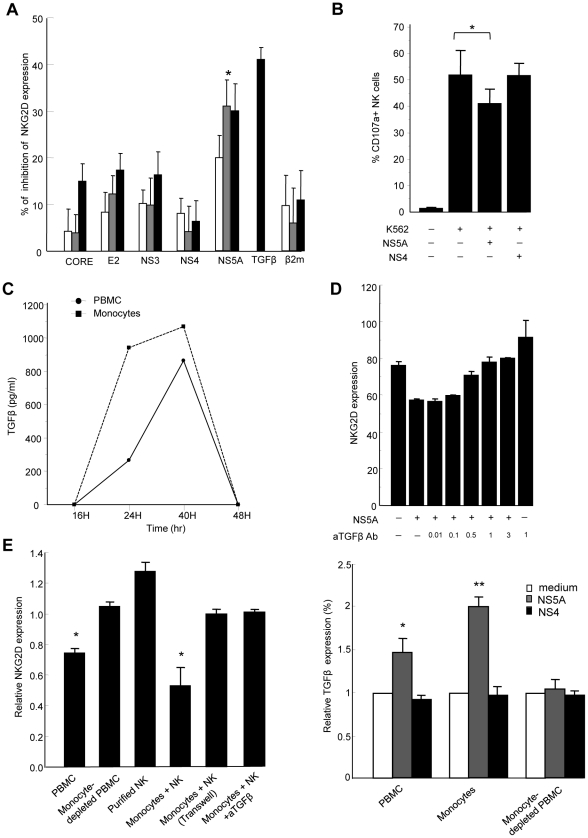
HCV-NS5A protein mediates TGFβ-induced downmodulation of NKG2D.A) Control PBMCs (0.2×106/ml) were stimulated with HCV-core, -E2, -NS3, -NS4, -NS5A or β2 microglobulin proteins at 0.1 µg/ml (white bars), 0.5 µg/ml (gray bars), or 1 µg/ml (black bars), or with recombinant TGFβ (10 ng/ml) for 48 h, and NKG2D expression was analyzed on CD3-CD56+ NK cells. Results are expressed as the percentage of inhibition of NKG2D expression in each condition relative to medium alone. Mean ± SEM of 3 independent experiments are shown. * P = 0.001. B) NS5A-mediated decrease in NK cell lytic potential. Control PBMCs were exposed to NS5A, NS4 or medium alone for 48 h, after which NK cell lytic potential to K562 target cells was evaluated by flow cytometry (CD107a expression). * P = 0.008. C) Kinetic analysis of TGFβ secretion upon 48 h stimulation of PBMCs (circles) or purified monocytes (squares) with 0.5 µg/ml of NS5A. TGFβ concentrations are given after background subtraction (cells cultured in medium alone). D) Pretreatment of PBMCs with increasing (0.01–3 µg/ml) concentrations of neutralizing TGFβ mAb prior to incubation with NS5A induces a dose-dependent increase of NKG2D on NK cells. E) Monocytes are the source of TGFβ upon NS5A stimulation. Left panel: The indicated cell populations were stimulated with 0.5 µg/ml of NS5A for 40 hr after which NKG2D expression was evaluated on NK cells. Results are expressed as NKG2D levels on NK cells in the indicated condition relative to the values in medium alone. NK cells were cultured with purified monocytes at the ratio of 1∶1 with or without Transwell (0.4 µm) separation or in the presence of 10 µg/ml anti-TGFβ mAb or isotype Ab. Data are mean ± SEM of 3 independent experiments. * P<0.002 for comparison with the values in medium alone. Right panel: Supernatants were harvested and assayed for TGFβ content. Values are normalized to TGFβ produced by cells cultured in medium alone and represent the mean ± SEM of 4 independent experiments. * P = 0.006, ** P = 0.0003.